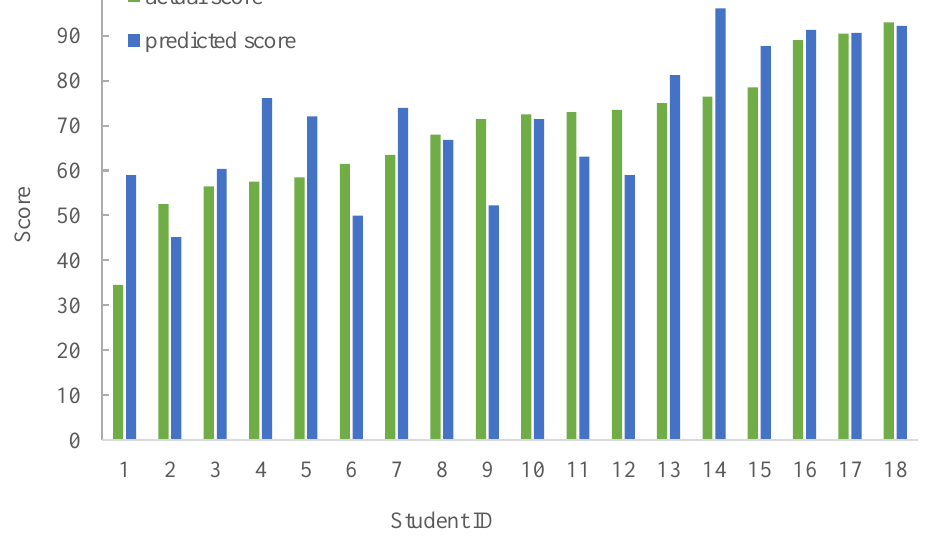
Figure 5. Comparison on predicted score and actual score of LR.